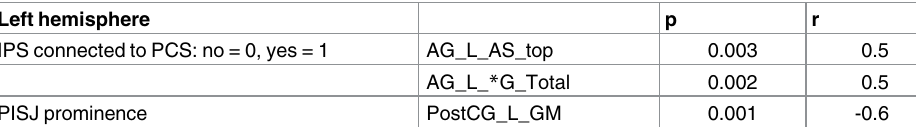
Relationships between the morphological characteristics and other variables listed in Tables 1 and 2. Spearman’s